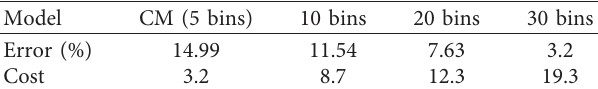
Figure 8: (a) The results of simulation by CM in different bins. (b) The results of simulation by QBMMs. Table 4: Computational time and error of simulation in different models.